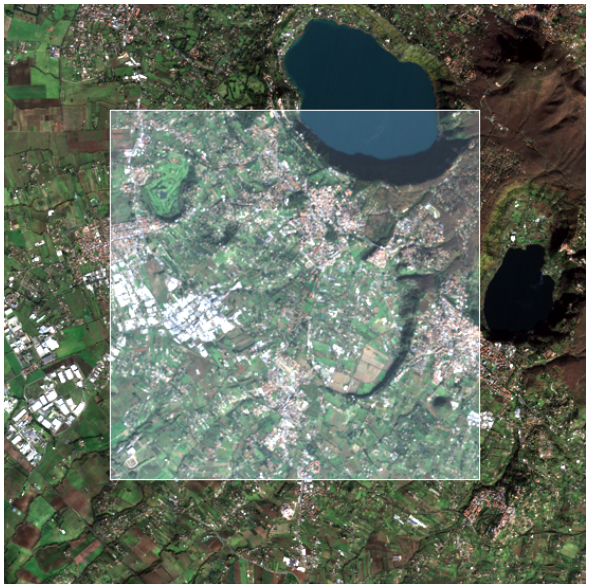
Figure 4. Alternative visualization option for an end user, in which a transparent cloud is simulated and overlaid to visually distinguish original image elements from synthesized